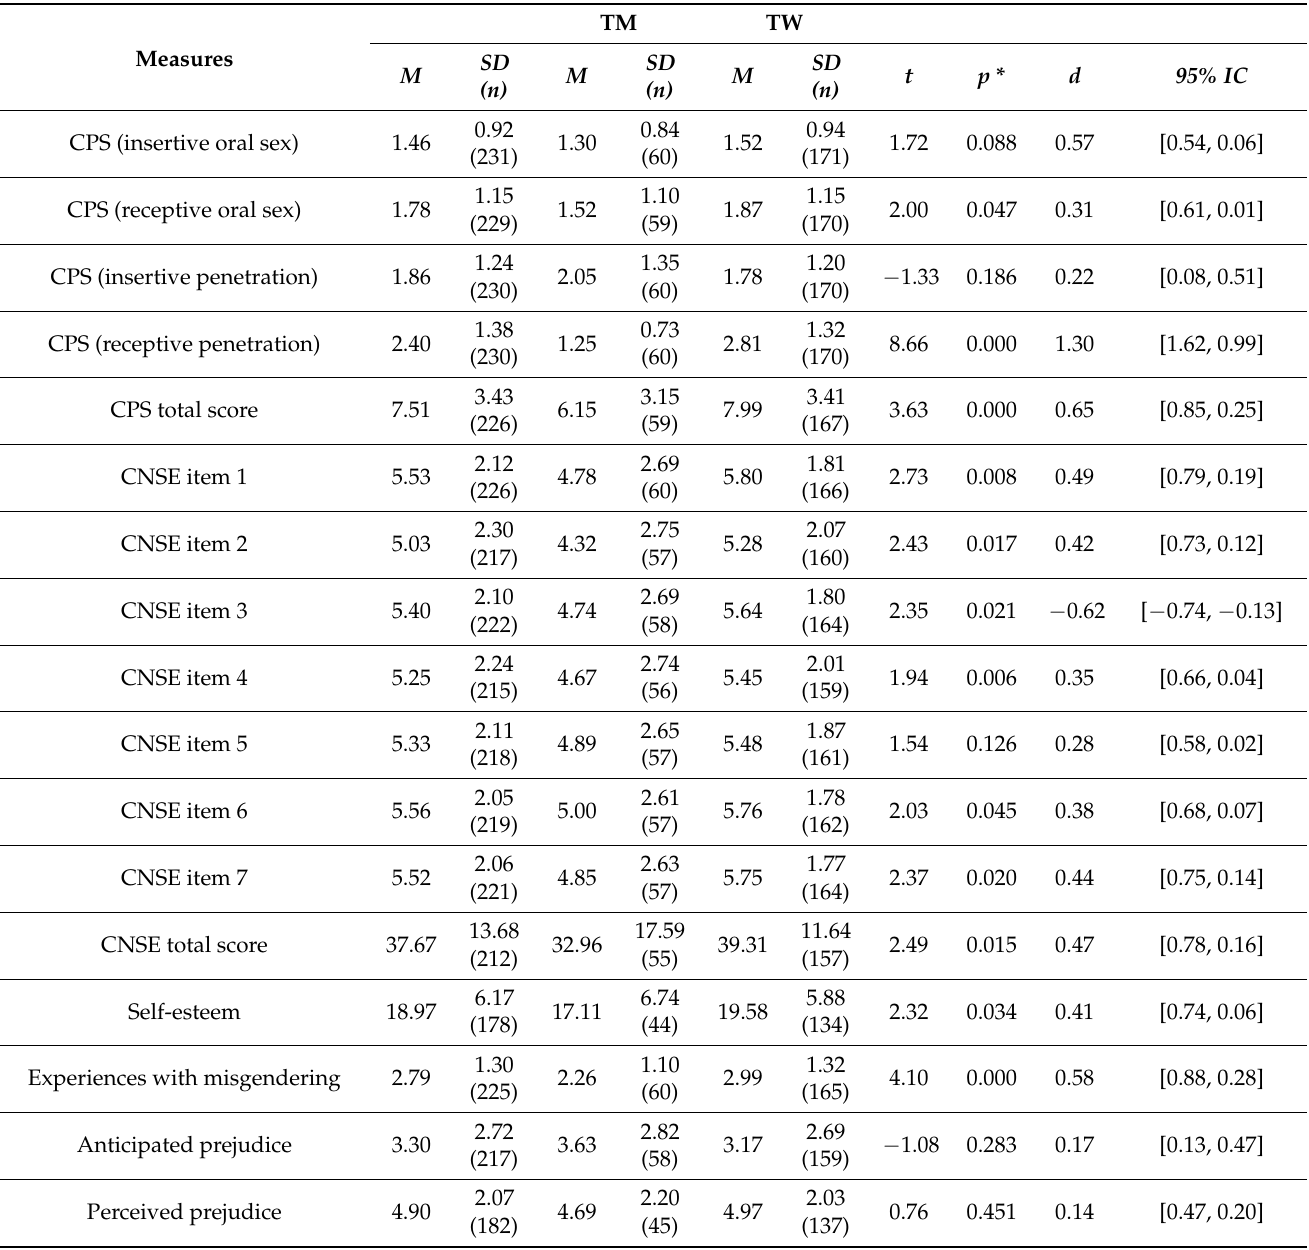
Table 2. Differences between TM and